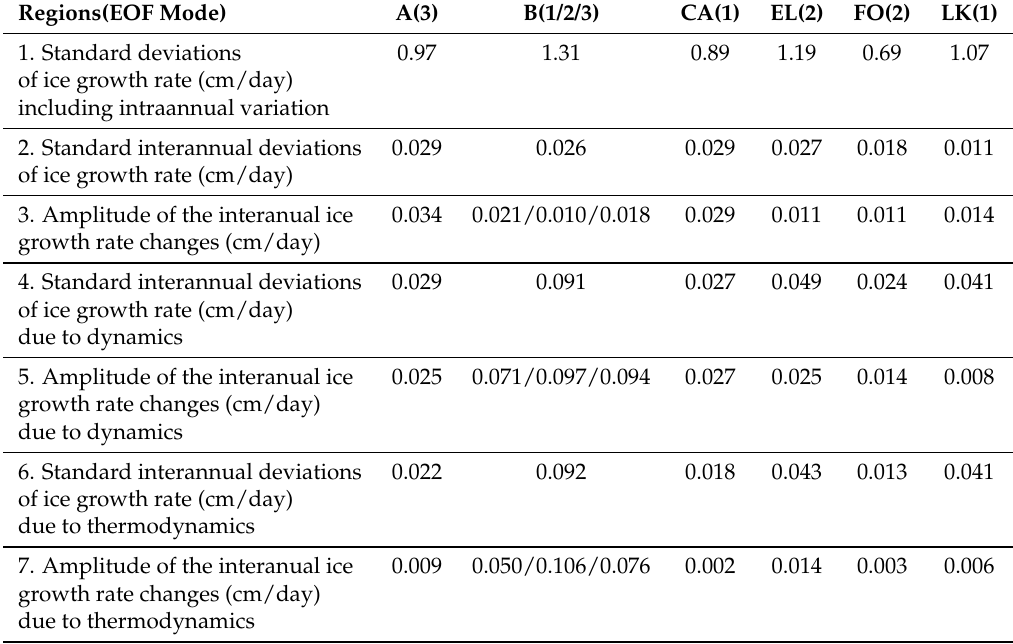
Table 2. Standard deviations of the ice growth rate and the amplitude (half the range) of changes in the ice growth rate associated with transition from negative to positive phase of one of the EOF